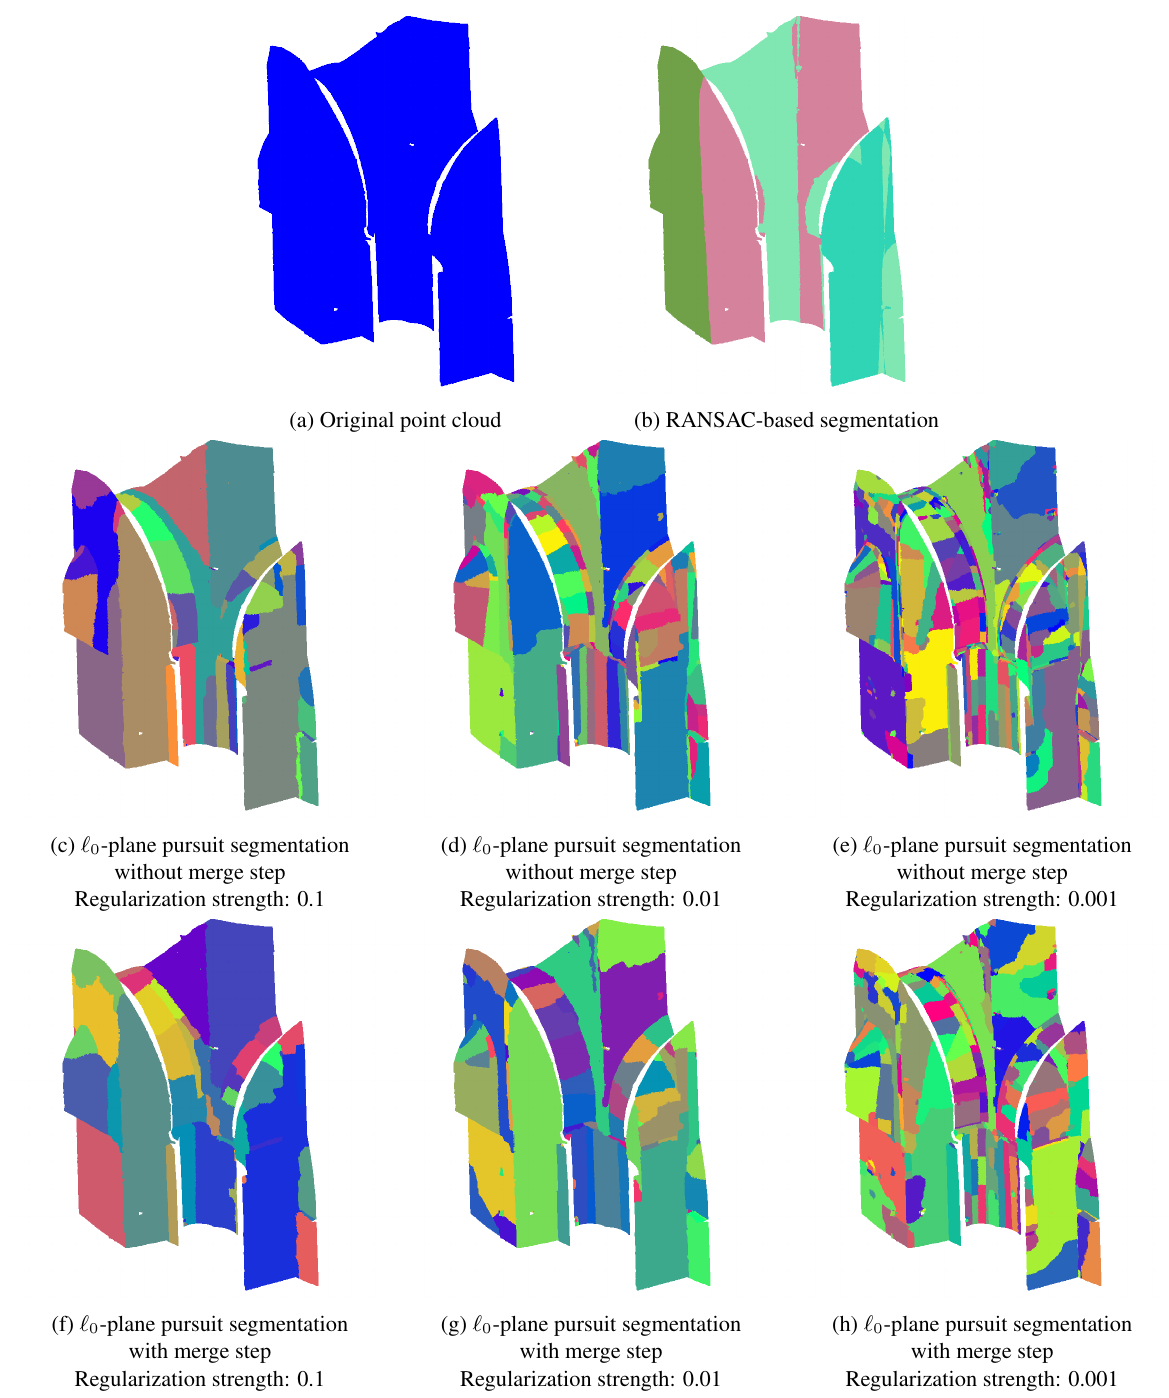
Figure 5. Scan of the inside of the chapel cloud, composed of walls and vaults. Each color corresponds to a different region.